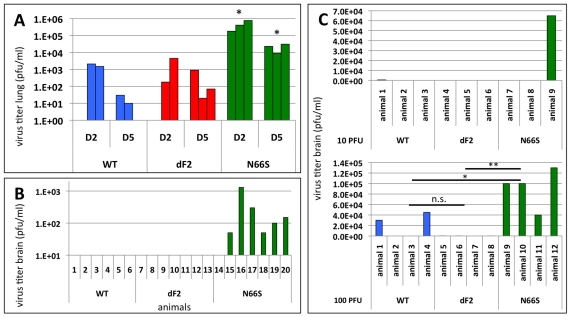
Effects of PB1-F2 expression on viral replication and spreading to the brain in mice.A) C57/BL/6/A2G-Mx1 mice were infected with 2.5×10E6 pfu of VN1203 wild type (blue), dF2 (red) or N66S (green). Viral lung titers were determined on day 2 and 5 post infection in 3 animals by standard plaque assay on MDCK cells. Titers of individual animals (pfu/ml) are depicted, the detect ion limit of the assay was 50 pfu/ml. P-values for the mean plaque titers are indicated (*p<0.05) using WT as standard. B) C57/BL/6/A2G-Mx1 mice were infected with 2.5×10E3 pfu of VN1203 wild type (blue), dF2 (red) or N66S (green). Viral brain titers on day 8 post infection of individual animals are depicted. The detection limit of the assay was 50 pfu/ml. C) Direct brain-inoculation of VN1203 wild type (blue), dF2 (red) or N66S (green) (10pfu upper panel, 100pfu lower panel). Viral brain titers (pfu/ml) 48 h post infection are shown for each animal.